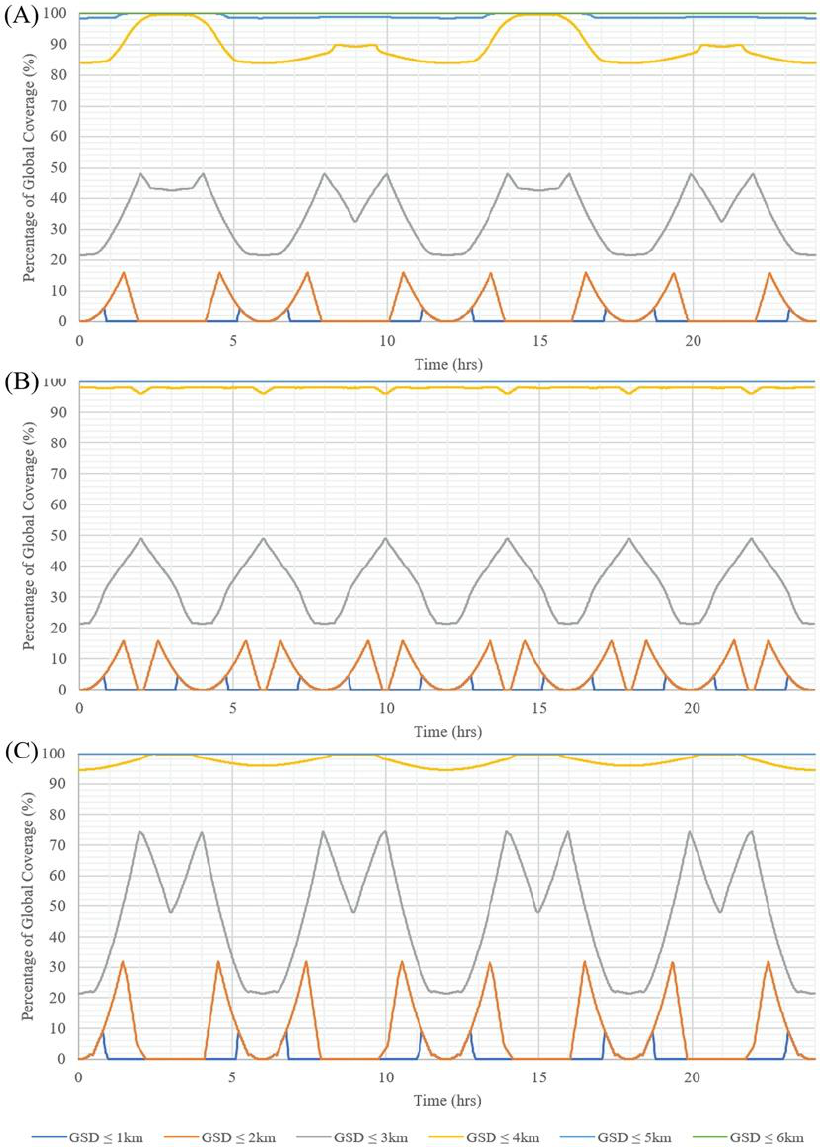
Figure 11. Percentage of global coverage at varying degrees of resolution for the ( A ) Nine, ( B ) Eleven, and ( C ) Thirteen satellite cases.